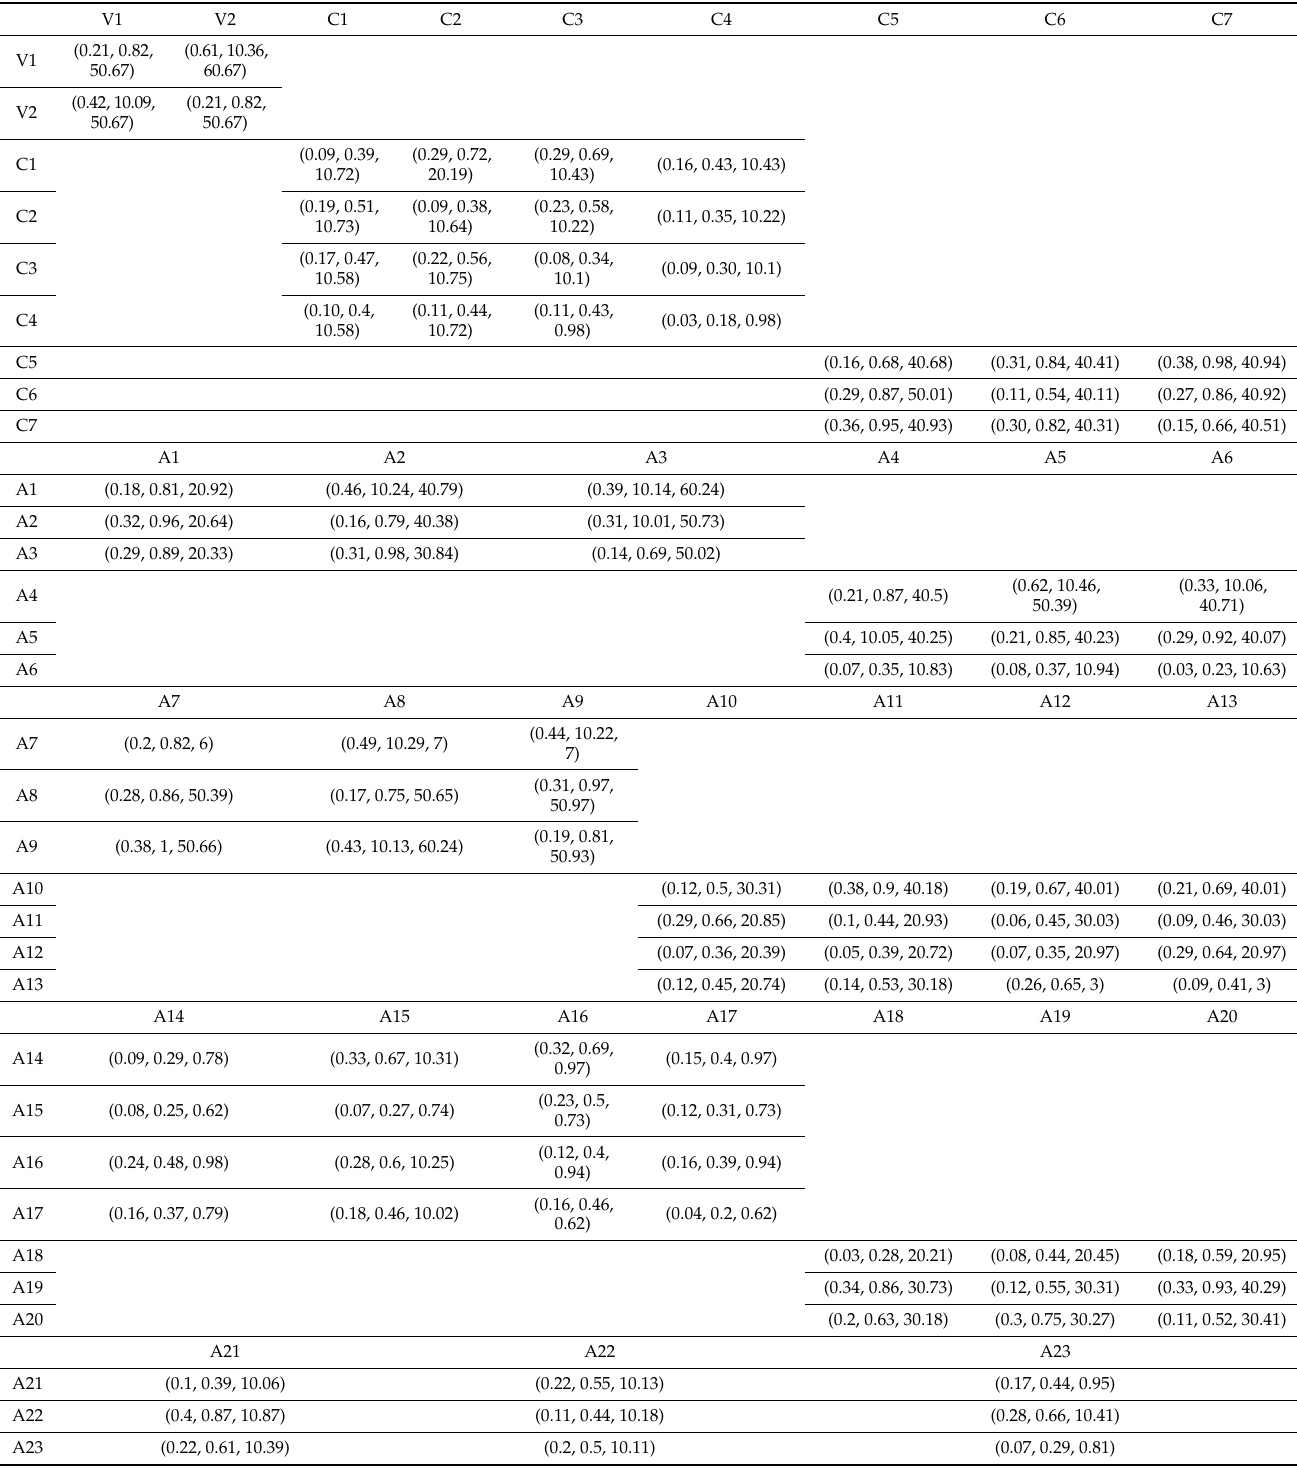
Table 4. Total relation